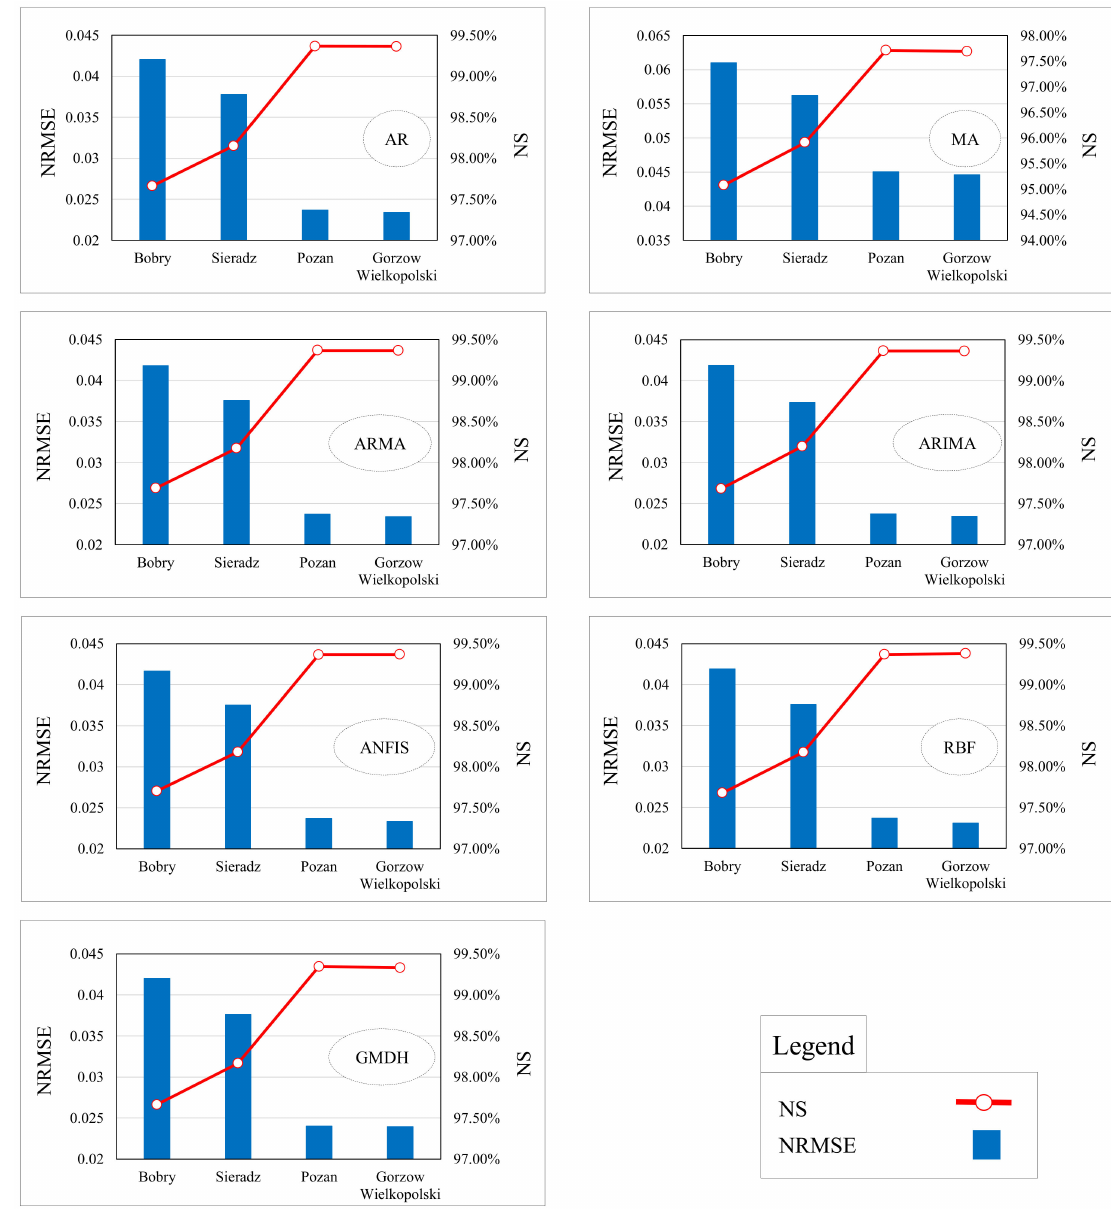
Figure 9. Comparing the TRW prediction accuracies between the hydrometric